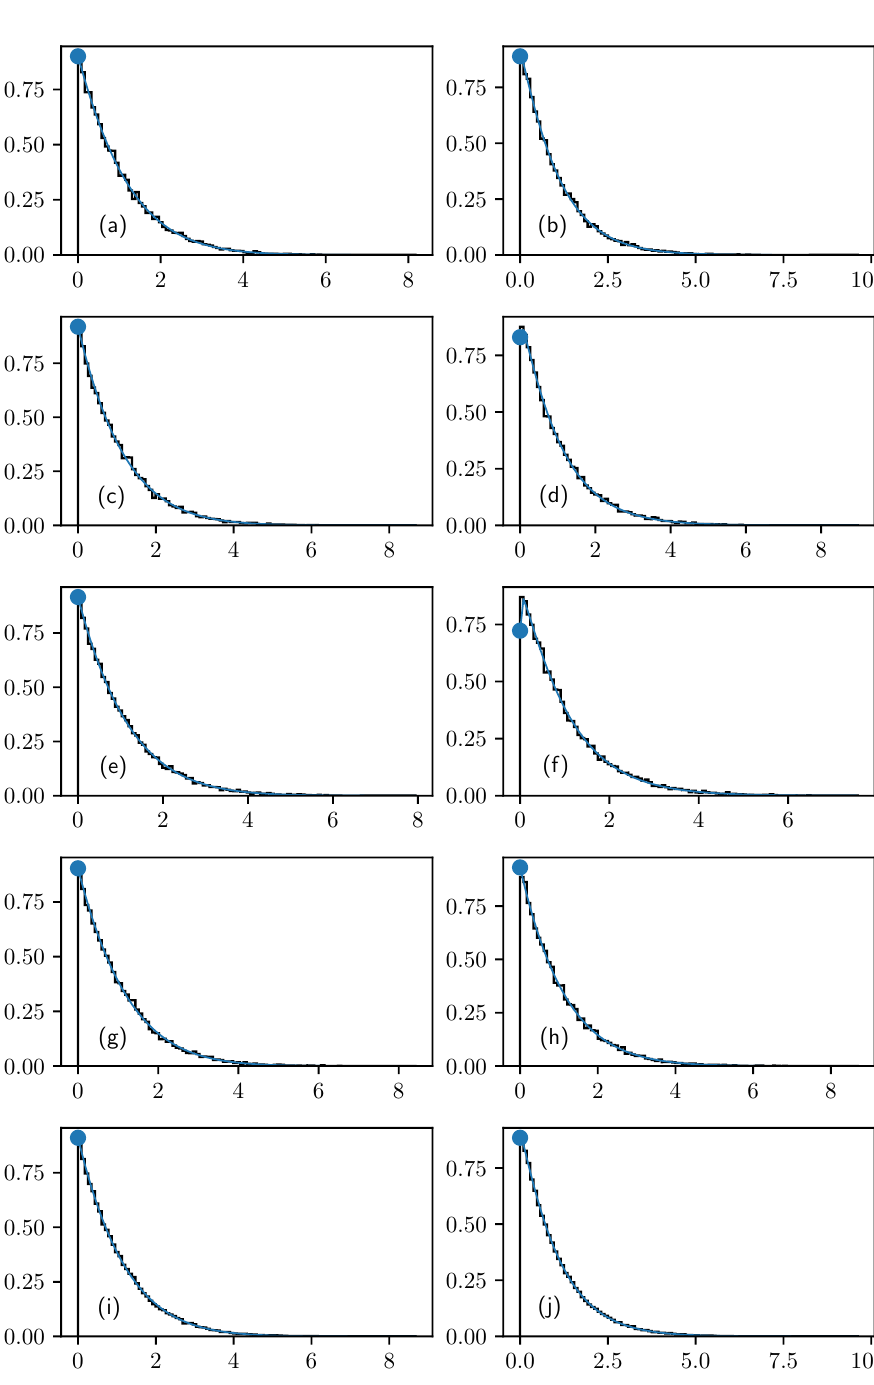
Figure 8. Level spacing distribution P ( S ) for the two billiards: of B = 0.1953 ( left column ) and of B = 0.083 ( right column ), along with the best fitting Berry–Robnik–Brody curves. The abscissa represents S and the ordinate gives P ( S ) . The full circles represent the value of P ( S = 0 ) . The parities are: even-even ( a , b ), even-odd ( c , d ), odd-even ( e , f ), odd-odd ( g , h ), and all parities together ( i , j ). For each particular parity, there are about 20,000 levels; for all parities together, there are about 80,000 levels. The values of ( β , ρ 1 ) for the left column are (top to bottom): (0.798, 0.684), (1.000, 0.716), (1.000, 0.709), (1.000, 0.690), (1.000, 0.700). The classical value ρ 1 = 0.7196. The values of ( β , ρ 1 ) for the right column are (top to bottom): (0.316, 0.666), (0.178, 0.588), (0.129, 0.474), (1.000, 0.738), (0.324, 0.660). The classical value ρ 1 =